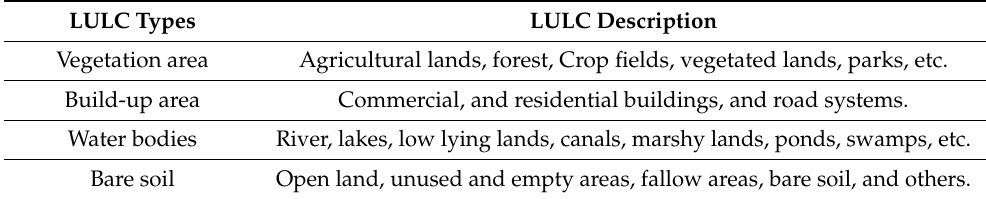
Table 2. Detail description of Land Use Land Cover (LULC)